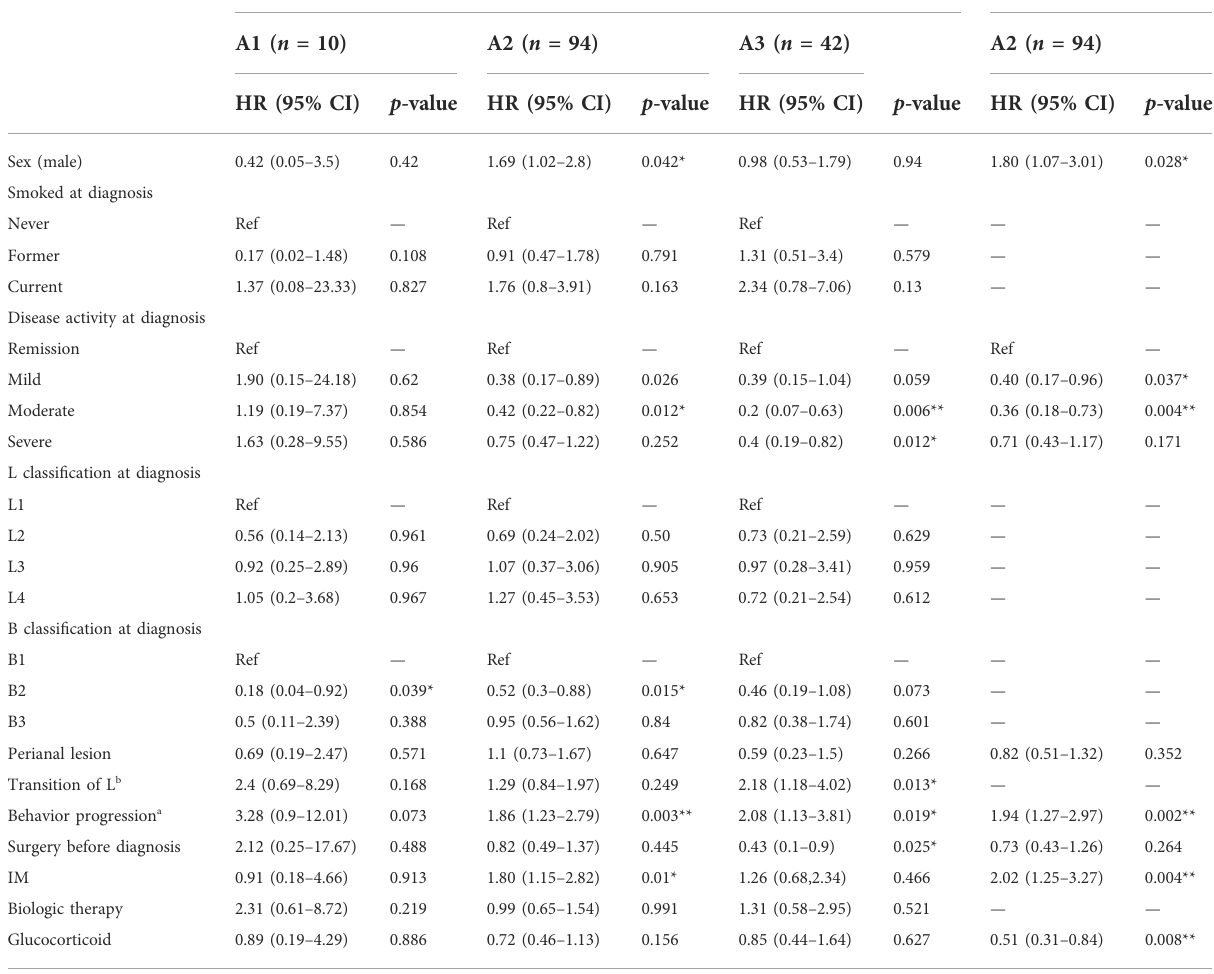
TABLE 3 Univariate and multivariate Cox regression analysis of risk factors for surgery after diagnosis among CD patients based on A classi fi